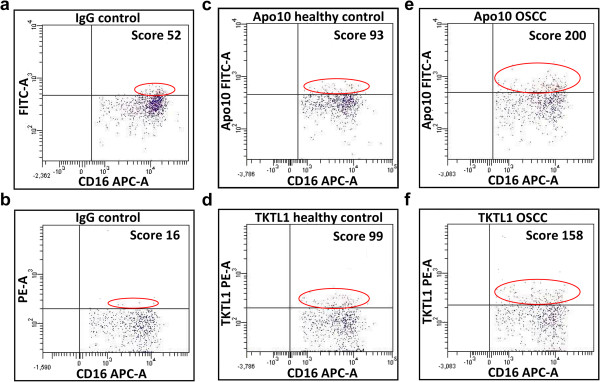
EDIM-dotplots of Apo10 and TKTL1 staining. Dotplots show isotype controls (background staining, a, Apo10; b, TKTL1), healthy control (blood donor, c, Apo10; d, TKTL1), a patient with OSCC (e, Apo10; f, TKTL1). Score values indicate the relative amount of positive macrophages. FITC-A (Fluoresceinisothiocyanate area) and PE-A (Phycoerythrin area), red population; APC-A (Allophycocyanin area) blue population.